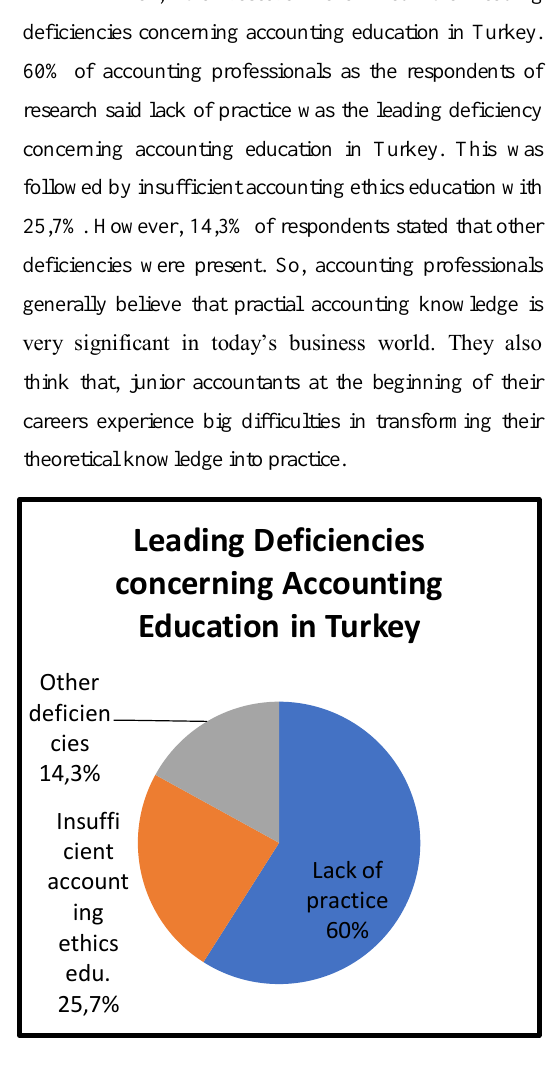
Figure 8. Leading Deficiencies concerning